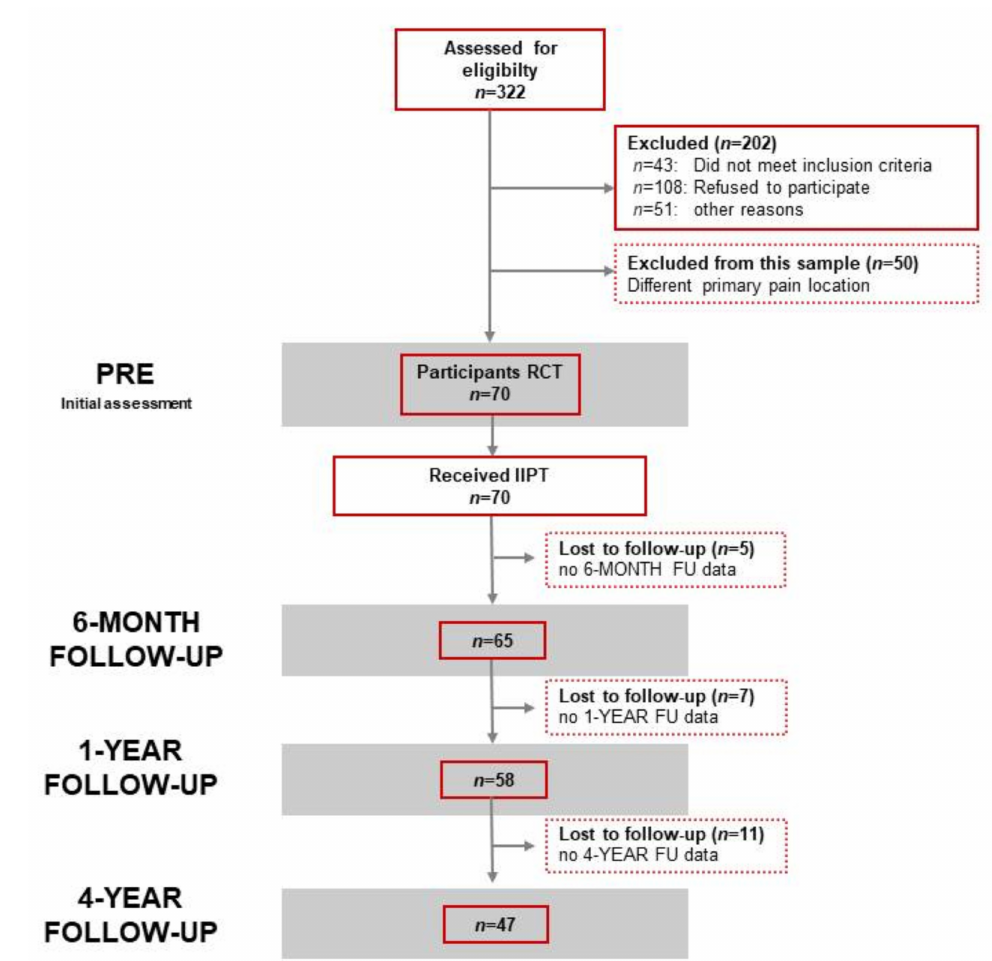
Figure 1. Flowchart for the chronic headache